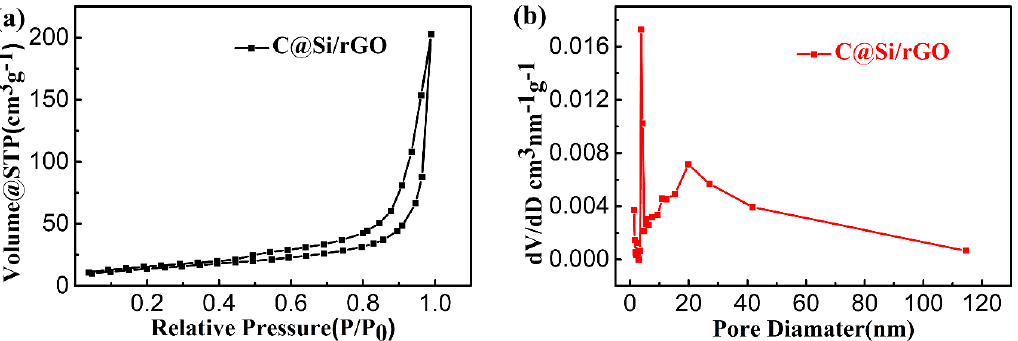
Figure 2. ( a ) Zeta potential of GO and PDDA@Si solution under different pH values. ( b ) XRD patterns of Si nanoparticle and C@Si/rGO film. ( c ) TGA curves of Si/rGO and C@Si/rGO film. ( d ) Raman spectroscopies of Si nanoparticle, Si/rGO film, and C@Si/rGO film.